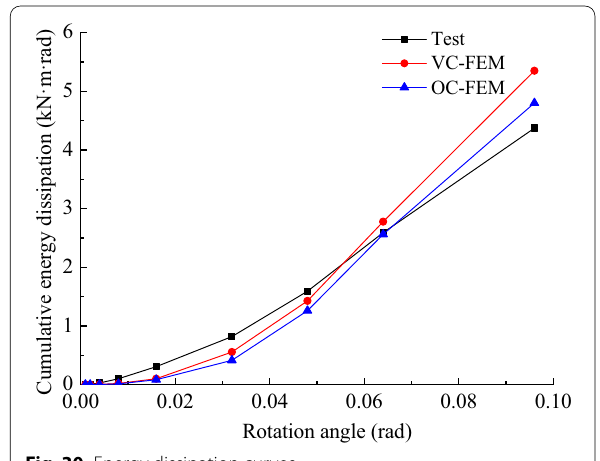
Fig. 30 Energy dissipation curves